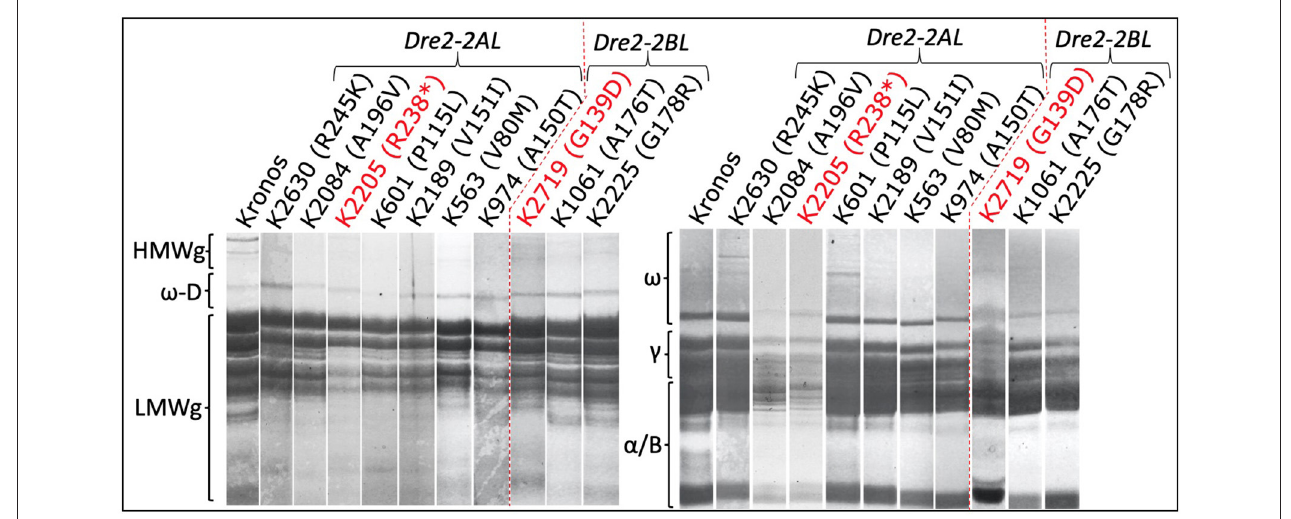
FIGURE 5 | Sodium dodecyl sulfate-polyacrylamide gel electrophoresis of gliadin and glutenin proteins from the DRE2 TILLING mutants. Notice the reduced or missing bands of different gliadins (right) and glutenins (left) in various DRE2 mutants.